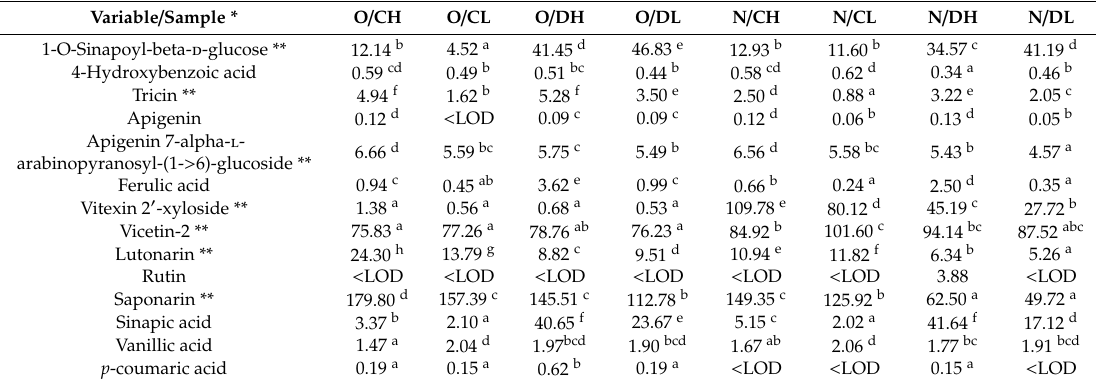
Table 6. Total phenolic content (GEA, mg / g DM) and phenolic compounds determined by LC-MS ( µ g / g DM). Variable / Sample *